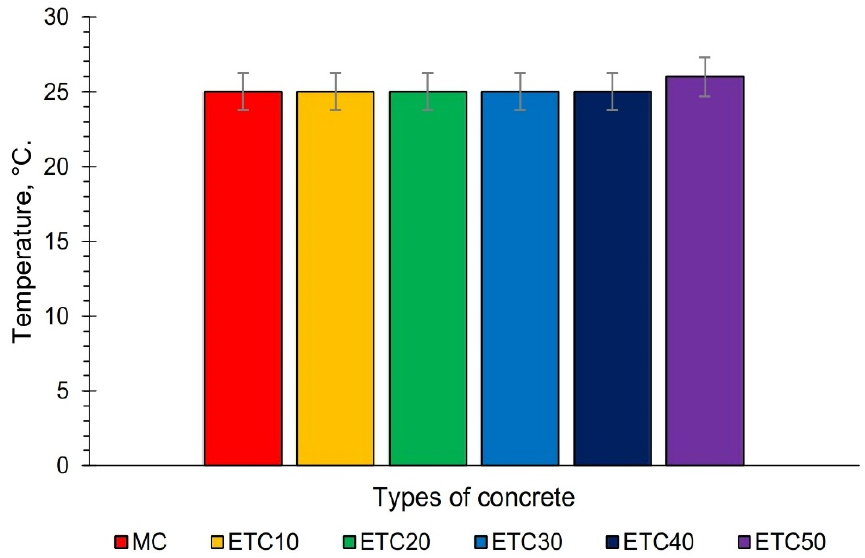
Figure 6. Temperatures of the studied concretes in fresh states.